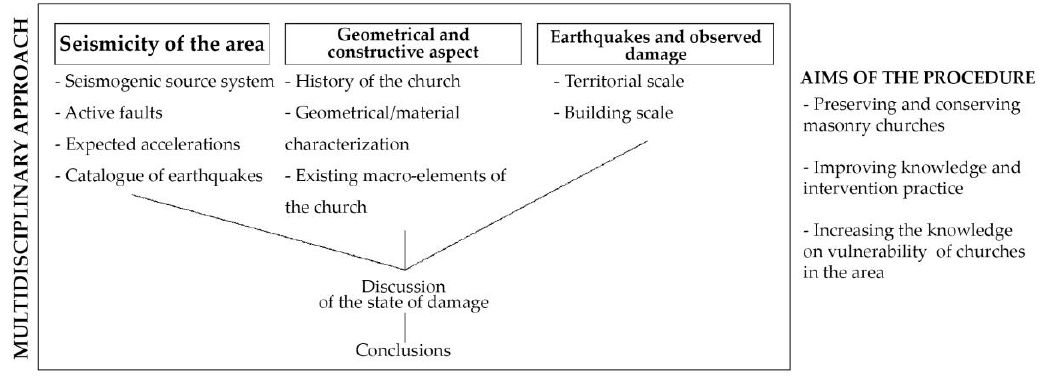
Figure 1. Diagram of the multidisciplinary procedure followed in the article.